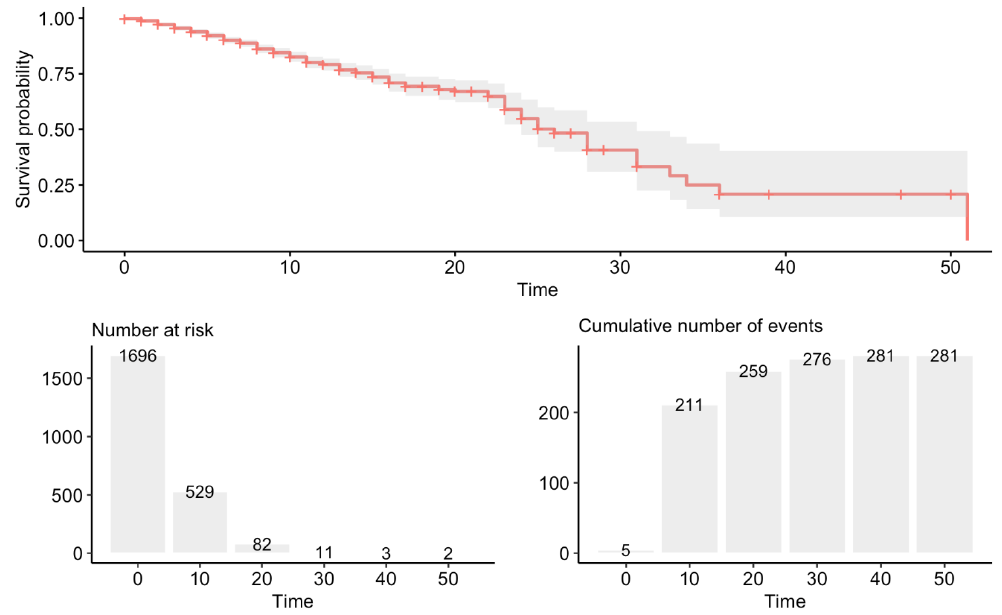
Figure 1. Survival probability over time.